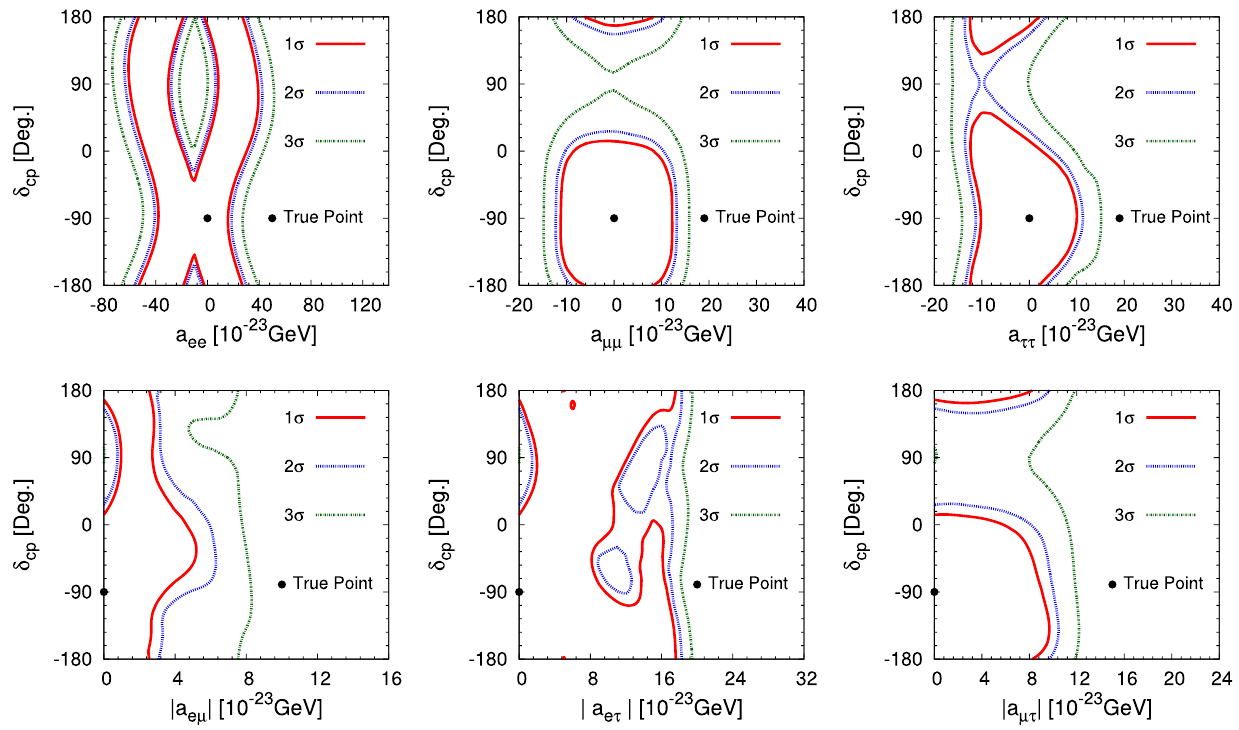
Fig. 10 Correlation between LIV parameters and δ CP in | a αβ | − δ CP plane at 1 σ , 2 σ and 3 σ C.L. for NO ν A